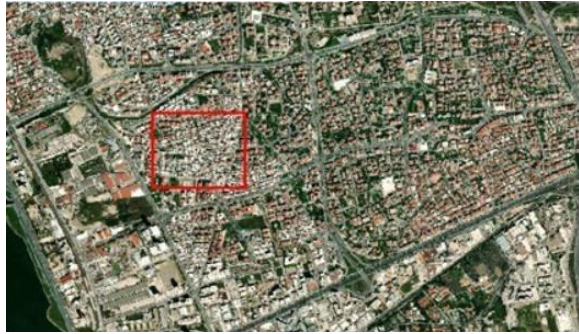
Figure 2. The investigated area is shown in red rectangle.